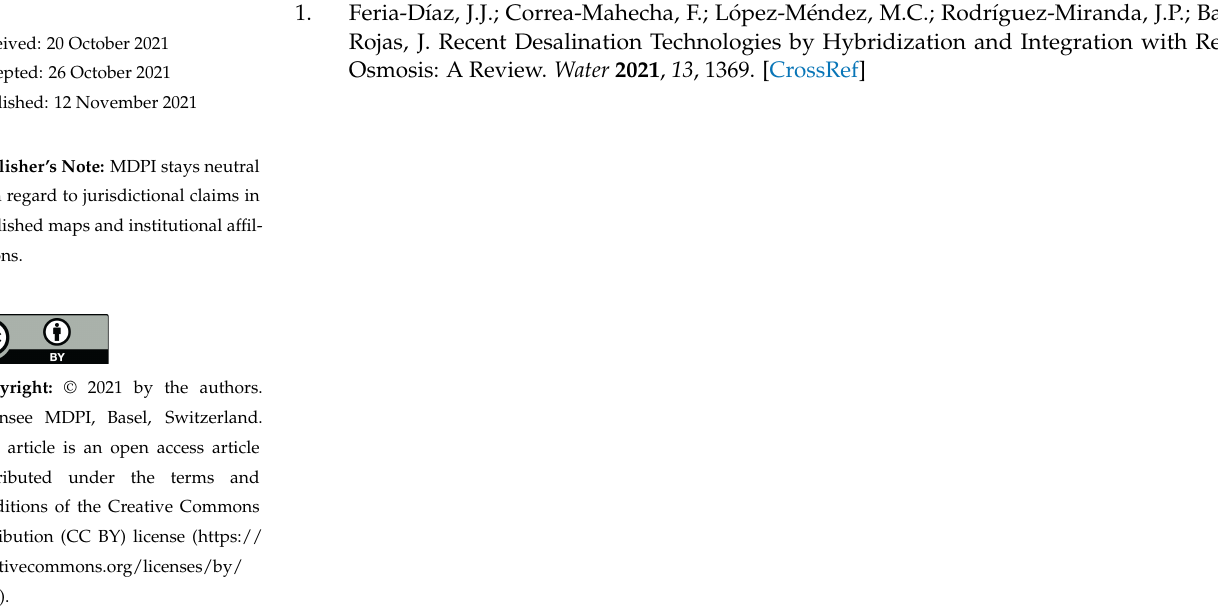
Figure 1. Membrane distillation operation with an air-gap configuration. Reprinted from Ref. [27]. Figure 3. Spiral wound membrane and driving force principles (inset) of RO. Reprinted from Ref.